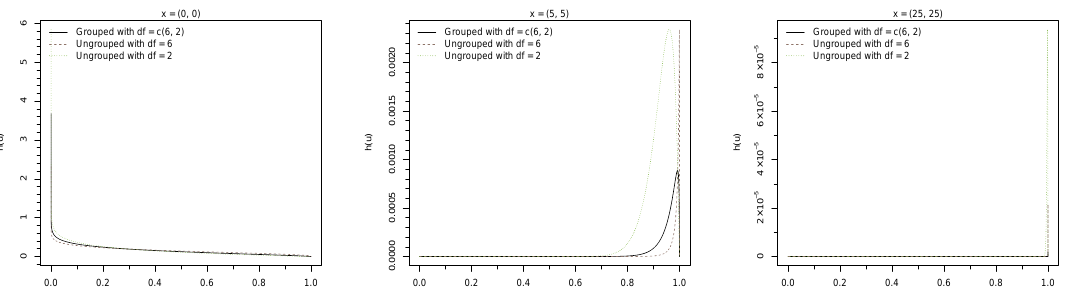
Figure 2. Integrand values h for a 2-dimensional distribution with t margins and x = ( 0,0 ) ( left ), x = ( 5,5 ) ( middle ) and x = ( 25,25 ) ( right